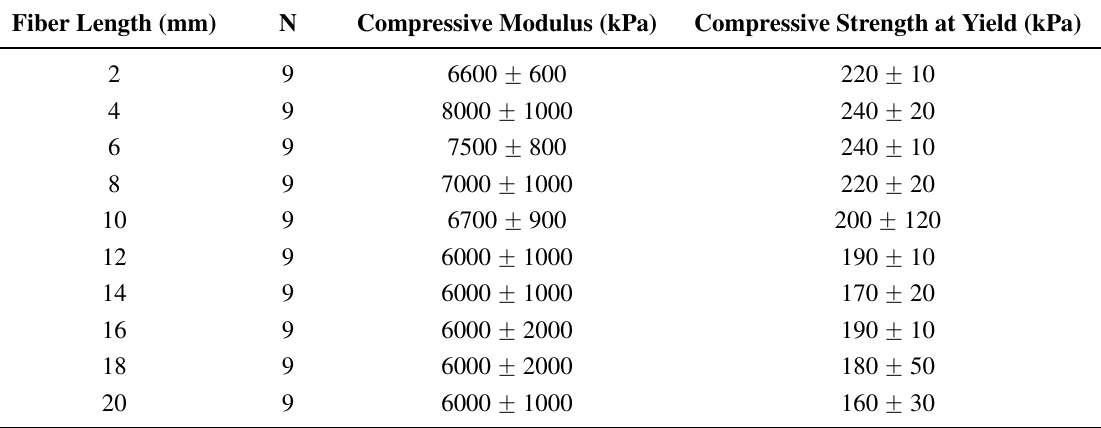
Table 6. Compressive moduli and yield strengths vs. fiber length for the soy silk compression